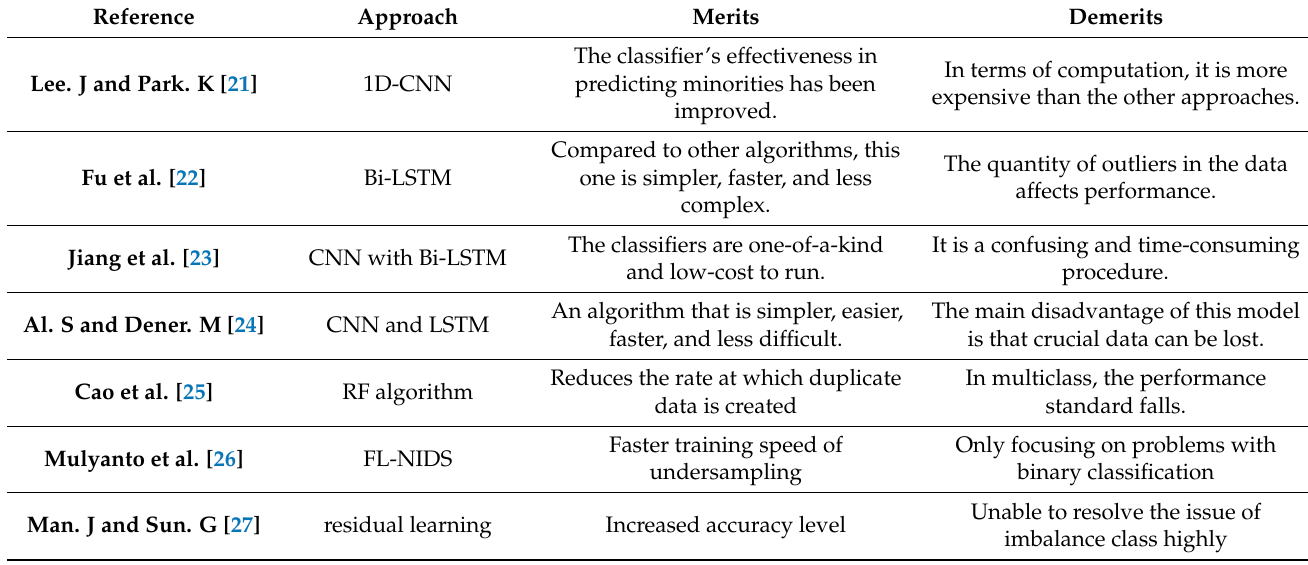
Table 1. Summary of existing